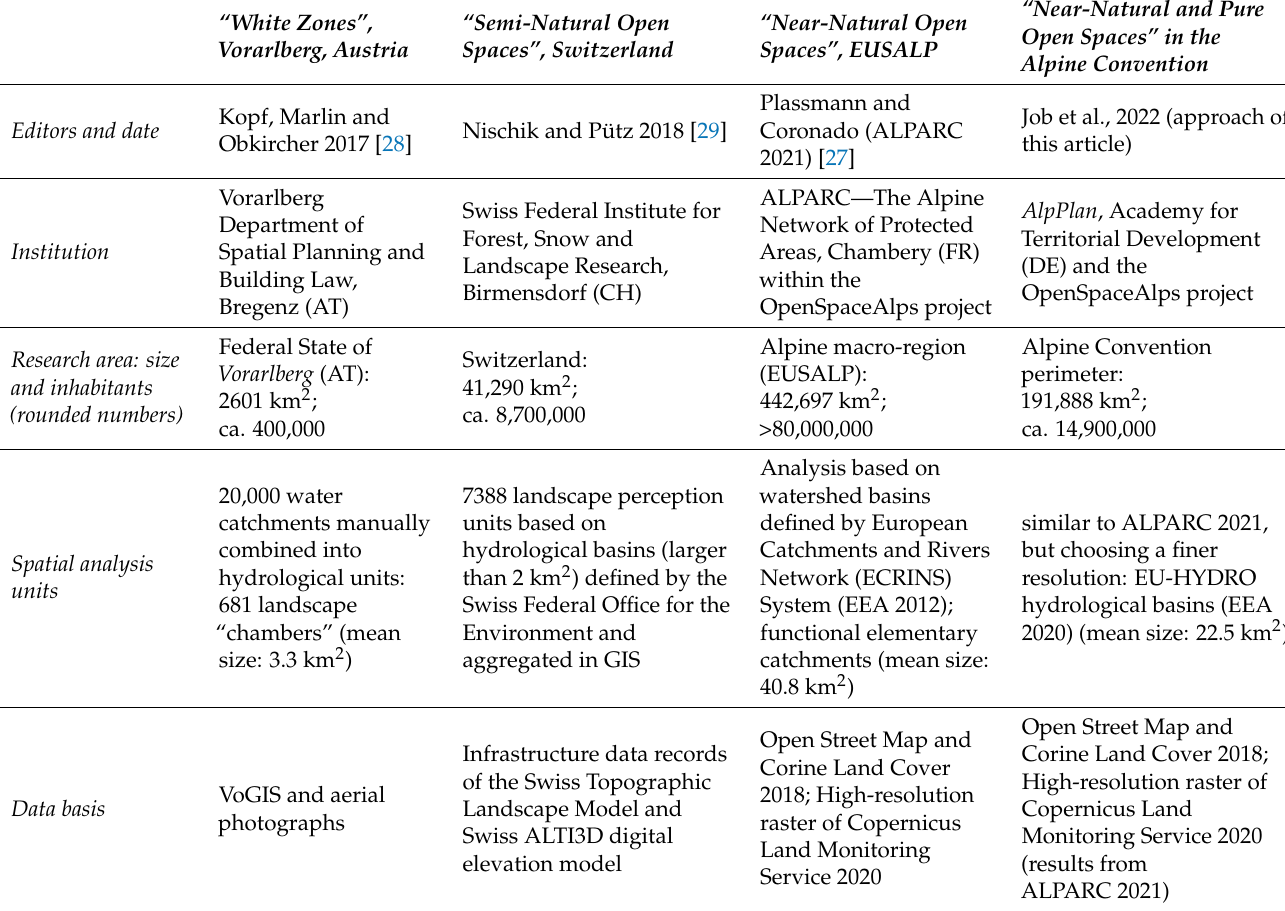
Table 1. Synopsis of GIS-based approaches of open spaces analysis in the Alpine region (Source: own